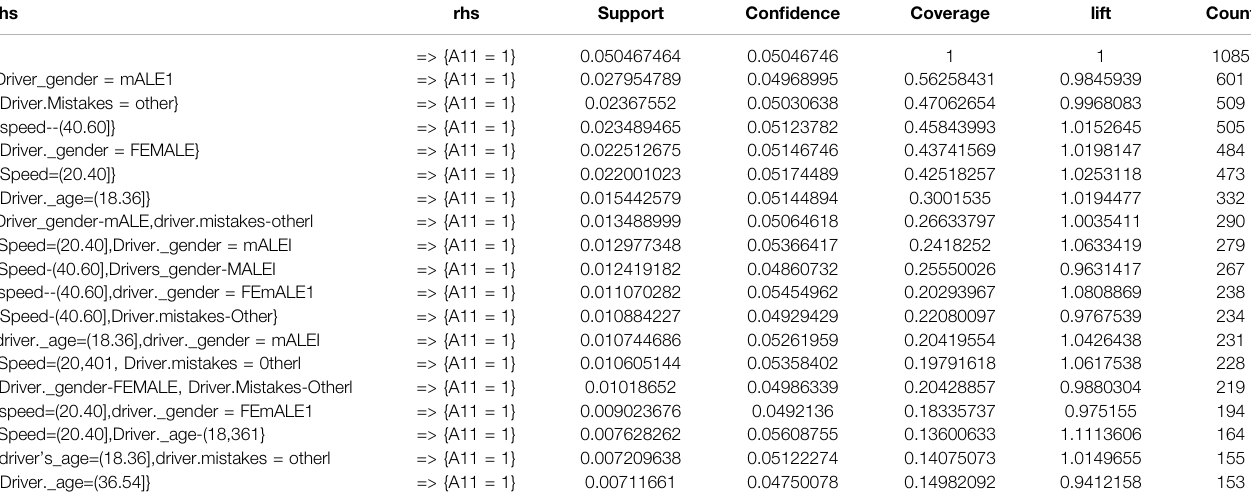
TABLE 8 | Effect of driver characteristic on traf fi c accidents.